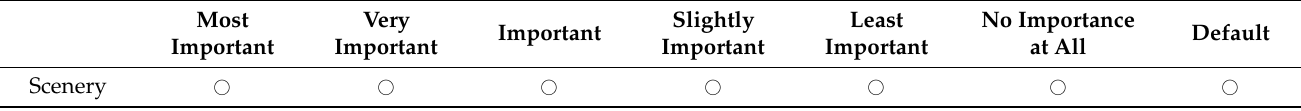
Table 3. Selection interface allowing drivers to select their